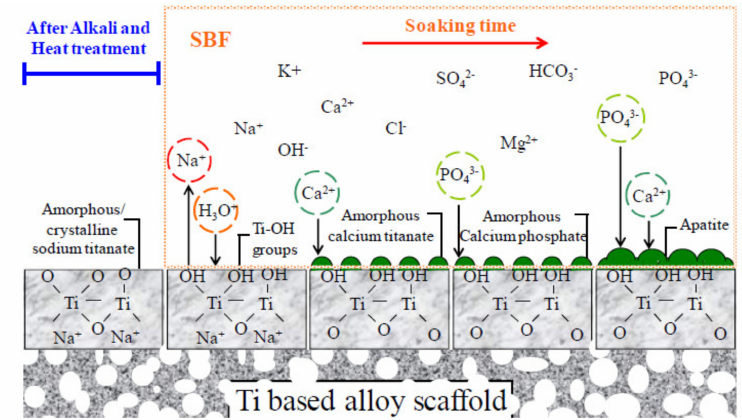
Figure 2. Scheme of the relationship in the process of formation of apatite on the surface structure when immersed in